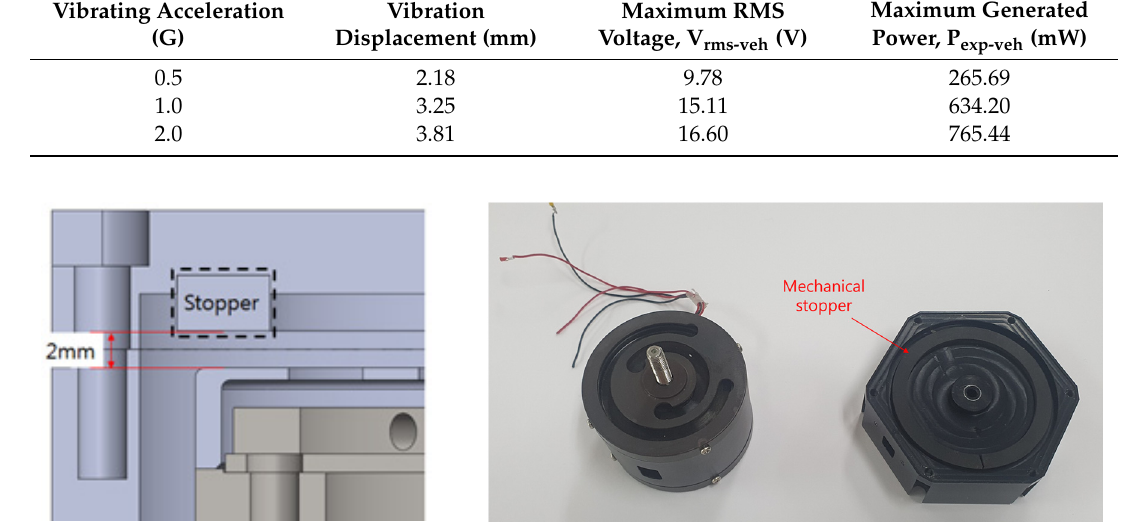
Figure 14. The maximum moving displacement of the spring was 2.0 mm with the mechanical stopper. As for the mechanical stopper, a ring-type of ethylene propylene diene monomers (EPDMs) ethylene rubber material was selected.